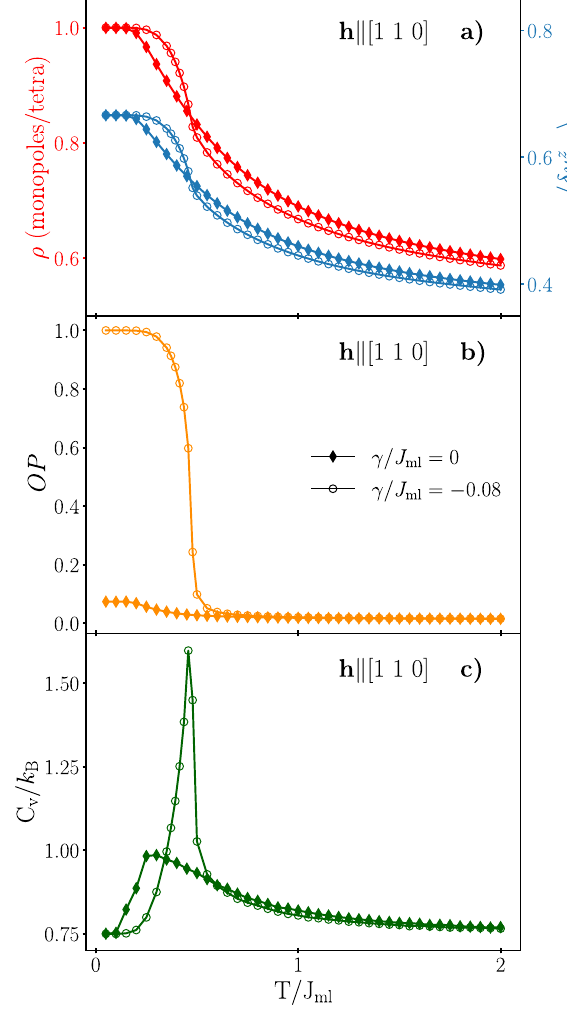
Fig. 5 The Magnetoelastic Spin Ice (MeSI) model in a symmetry breaking fi eld: the double-layered monopole crystal. Monte Carlo simulations as a function of temperature were performed using the extended MeSI model (Eq. (7)) for a fi xed magnetic fi eld h ∣∣ [110], with h / J ml = 13.4 and 8192 spins. The extended model indirectly takes into account magnetostriction effects using inhomogeneous exchange constants J ij , 0 ¼ J þ η z ¼ J (cid:2) δ ð h Þ and J 24 ¼ modifying J 0 according to symmetry: J 13 0 0 0 0 J (cid:2) η z ¼ J þ δ ð h Þ (see Fig. 1b)); the other exchange constants for the 0 0 undisplaced O − 2 were kept constant at the value J 0 . In order to guarantee a spin ice-like phase at zero fi eld, J 0 / J ml = 1.1, δ (0)/ J ml = 0, and δ ( h )/ J ml = − 0.5. Curves with fi lled symbols where obtained using Eq. (7), while those with open symbols are the equivalent after adding an effective charge- charge interaction (Eq. (6)) with γ / J ml = − 0.08. a Monopole density ρ i (right (left) and average staggered O displacement along z − axis, h δ u z stagg axis) as a function of temperature. b Order parameter for the crystal ( OP ) as a function of temperature. c Speci fi c heat ( C V ) vs temperature. The attraction between like charges (Eq. (6)) leads to an spontaneous symmetry breaking transition into the magnetic and structural phase shown in Fig. 4. It is re fl ected in the abrupt changes seen in all the curves near T / J ≈ ml